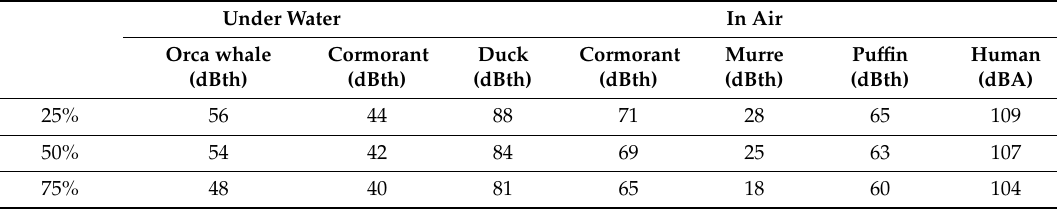
Figure 3. In-air ( a ) received power spectral density (PSD) from 23 overflights (grey), and median (blue) and quartile (red and green) levels. ( b ) One-third octave band levels (median and quartiles; blue, red, and green, respectively) are compared to the in-air audiograms of cormorants, ducks (i.e., lesser scaup), murres, and puffins. Noise above the audiogram lines is expected to be audible. Table 1. Median and quartile audiogram-weighted levels (dBth) for killer whales and seabirds, and A-weighted levels for humans.